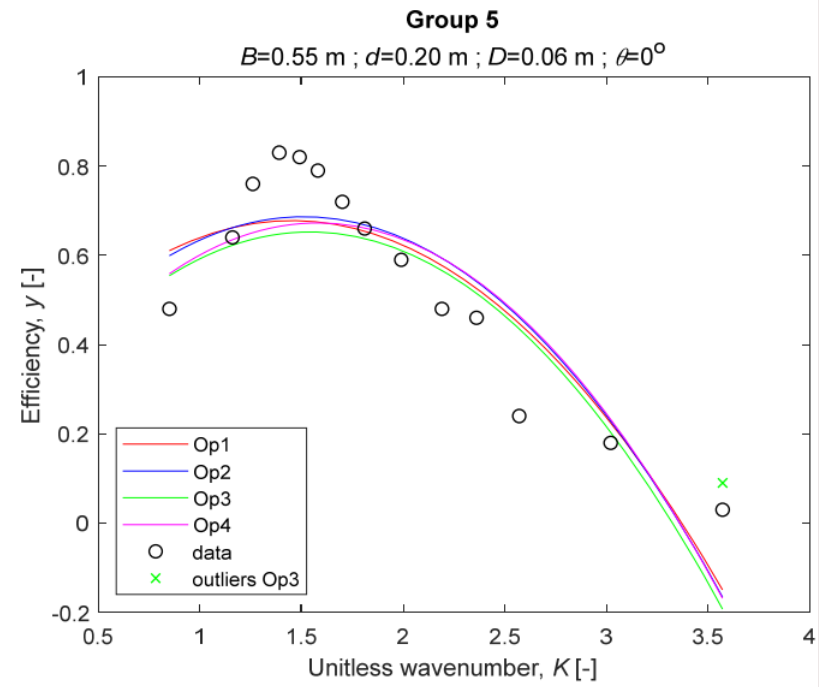
Figure 7. The four models for Group 5. The outliers for a model are denoted above the point with a cross in a respective color.